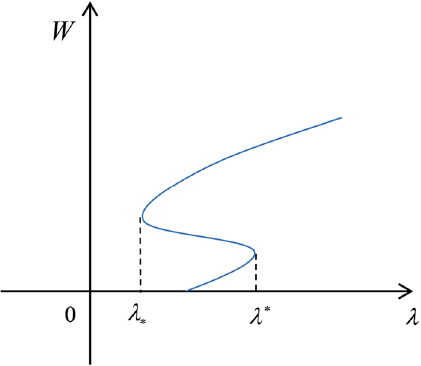
Figure 1: S - shaped connected component of positive solutions of problem ( 1.1 )